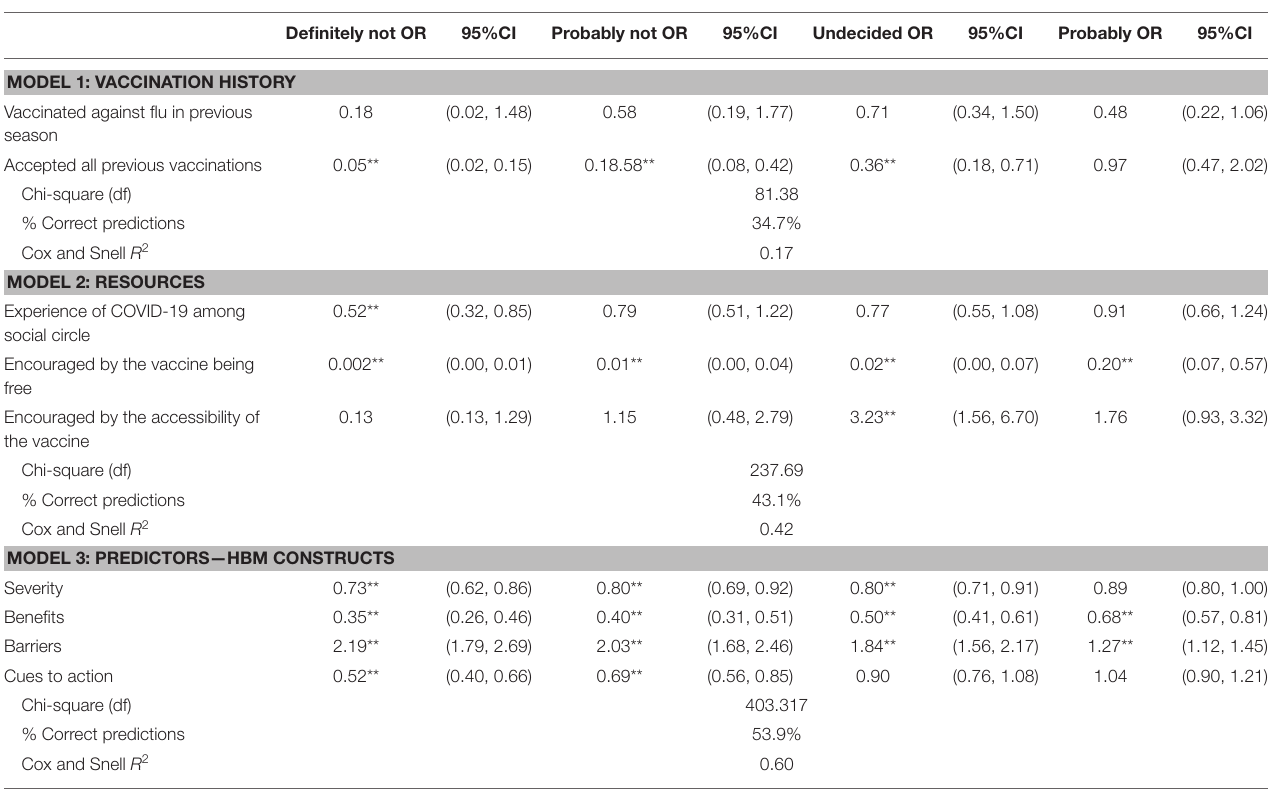
TABLE 4 | Multinomial logistical